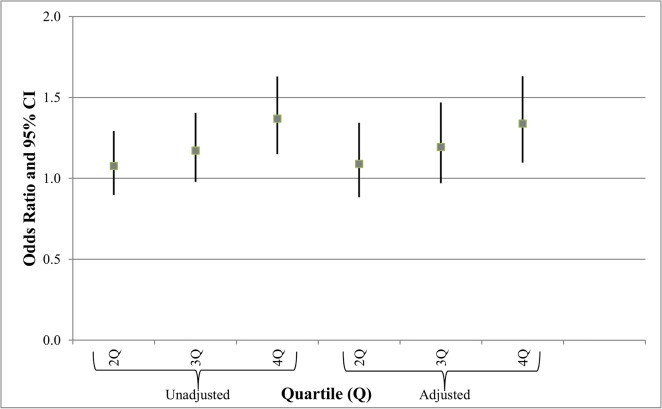
Unadjusted and adjusted odds ratios (OR) and 95% confidence intervals (CI) for small for gestational age (adjusted for mom’s age, mom’s education, pre-pregnancy weight, gender of infant, prenatal visits, smoking during pregnancy, gestational diabetes, WIC, race, and birth order).Key: Referent (First quartile), <0.87 wells per mile; Second quartile (2Q), 0.87 to 2.59 wells per mile; Third quartile (3Q), 2.60 to 5.99 wells per mile; Fourth quartile (4Q), ≥6.00 wells per mile.